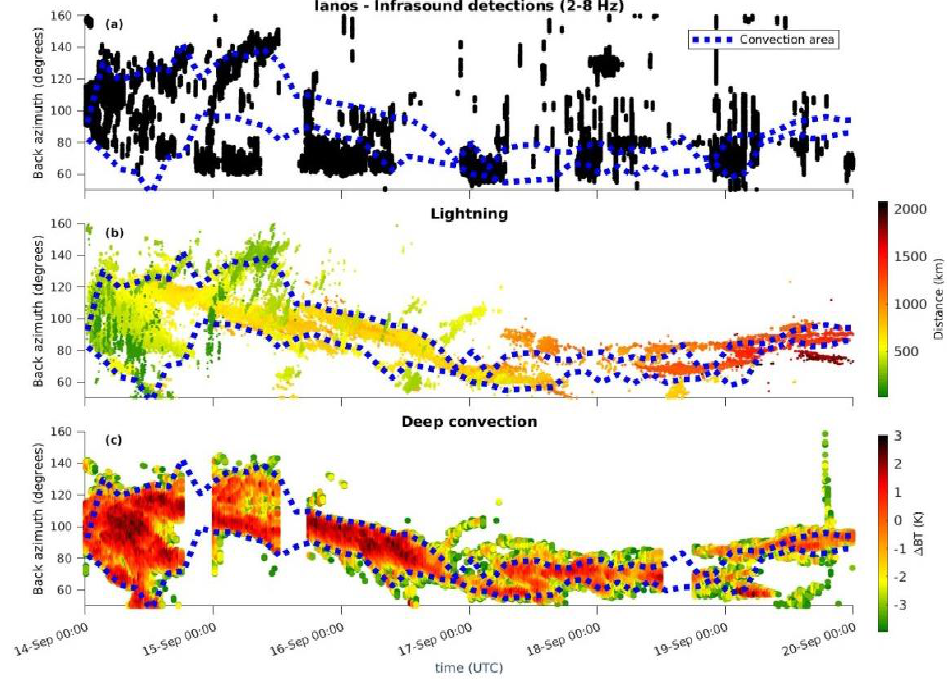
Figure 14. Same as Figure 13, but for